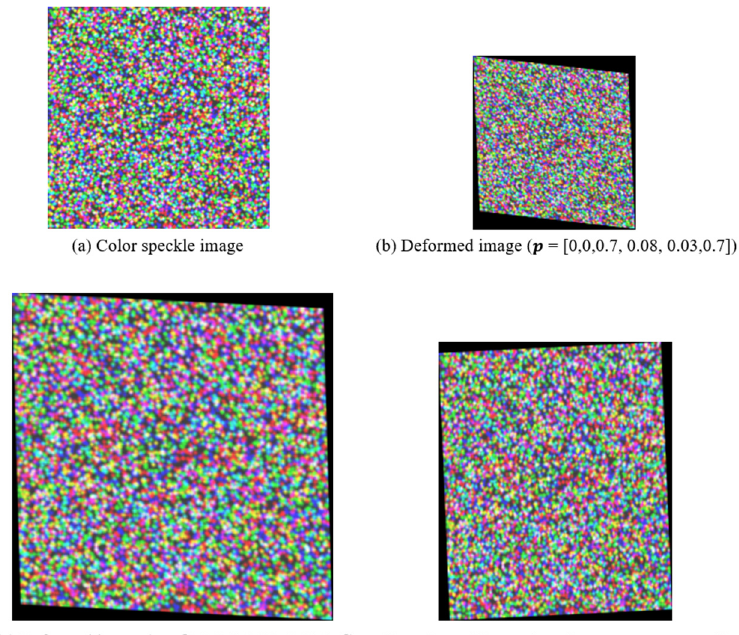
Figure 5. A series of generated speckle images with different scales (where ( b – d ) are deformed by ( a ) according to different deformation parameter).